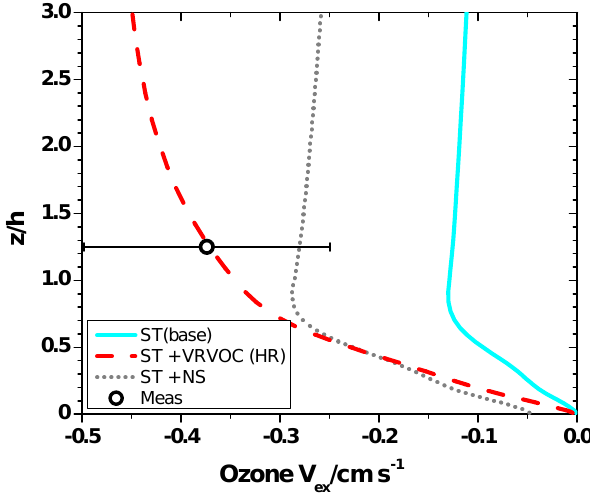
Fig. 2. Vertical profiles of modeled ozone exchange velocity for the base scenario (stomatal deposition only), the HR scenario (stomatal deposition and VRVOC reactions) and a model scenario using de- fault resistances for non-stomatal deposition. The measured value (mean ± 1 σ ) is also